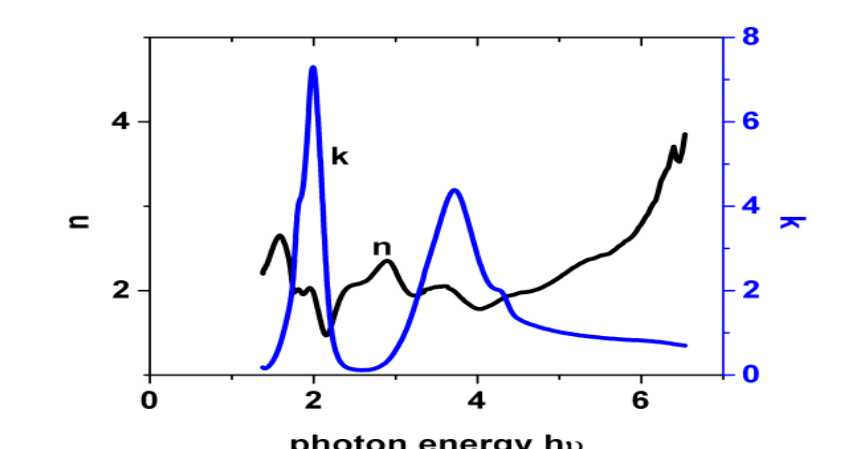
Figure 4. The refractive index and the extinction coefficient of ZnTTBPc as a function of photon